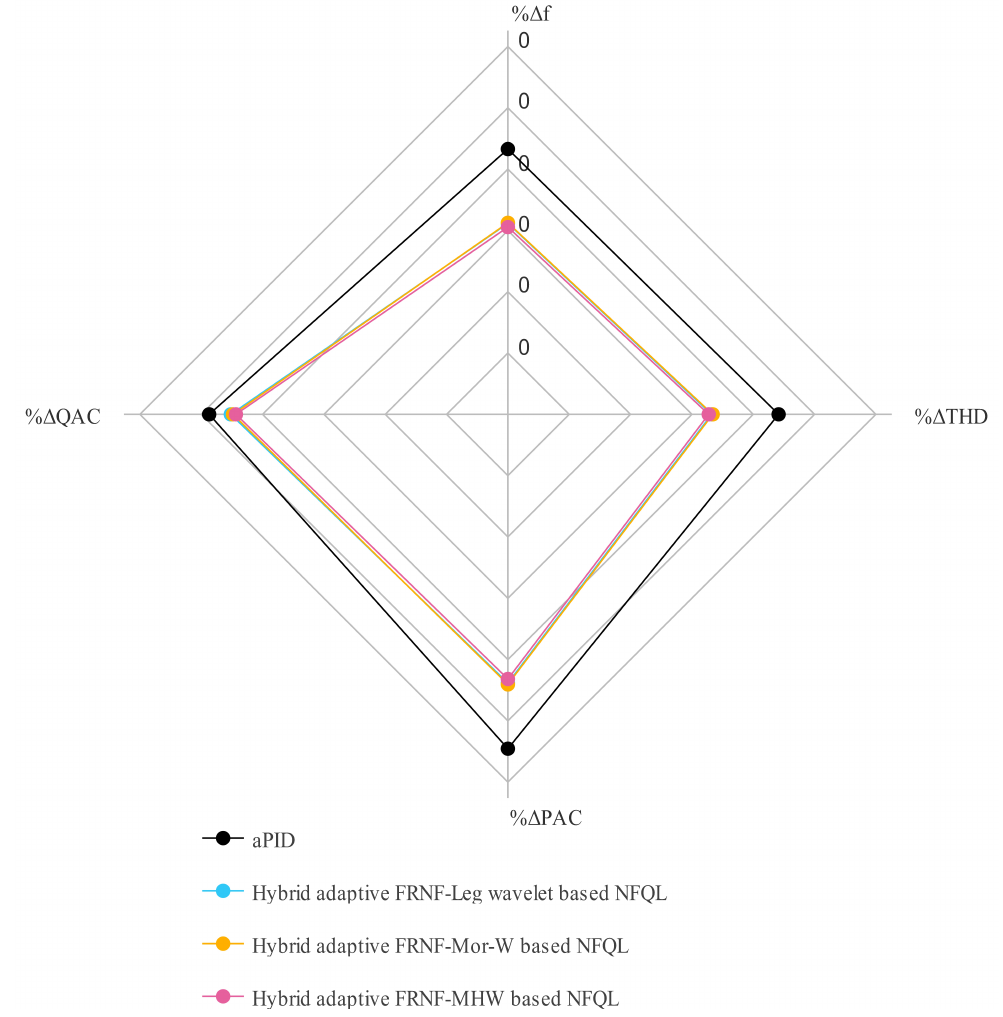
Figure 20. Spider chart of comparable parameters for interlinking converter